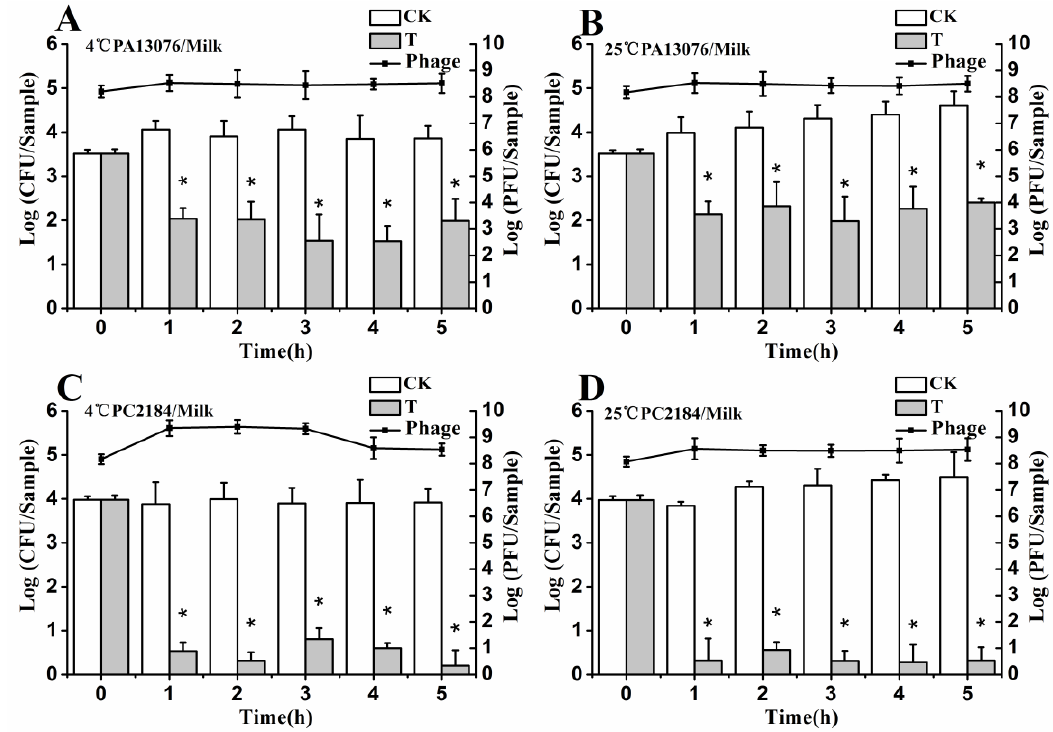
Figure 5. Effects of individual phages on growth of SE ATCC13076 and CVCC2184 in milk samples at 4 °C and 25 °C. Each milk sample was inoculated with either SE ATCC13076 ( A , B ) or SE CVCC2184 ( C , D ) (1 × 10 4 CFU), and phage PA13076 or PC2184 was applied (1 × 10 8 PFU) later (CK, inoculated control without phage; T, treated with phage). The titers of phage were also detected each sampling time (indicated in a dotted line). Date represent the mean ± S.D. ( n = 3), * represents p < 0.05 (Duncan’s test).